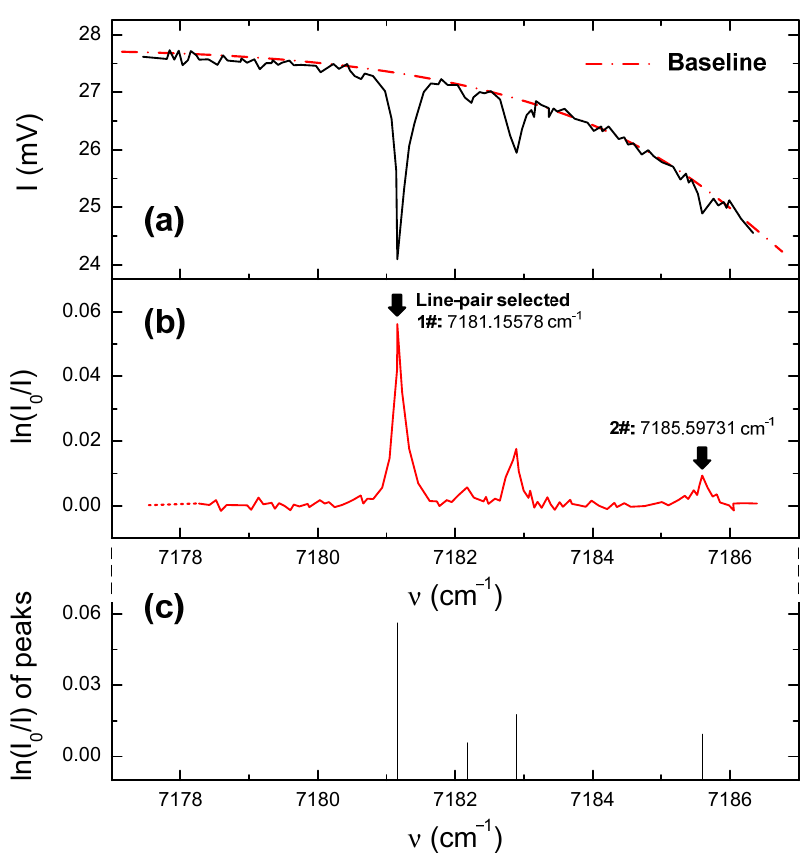
Figure 5. ( a ) Absorption frequency-domain diagrams of the transmitted light intensity and ( b ) the absorption ratio with ( c ) main peak positions and absorption ratio with ( c ) main peak positions and strengths.